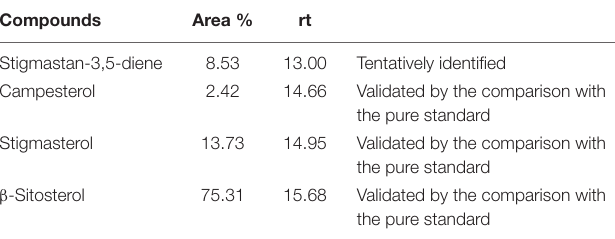
TABLE 1 | Compounds identified in chloroform